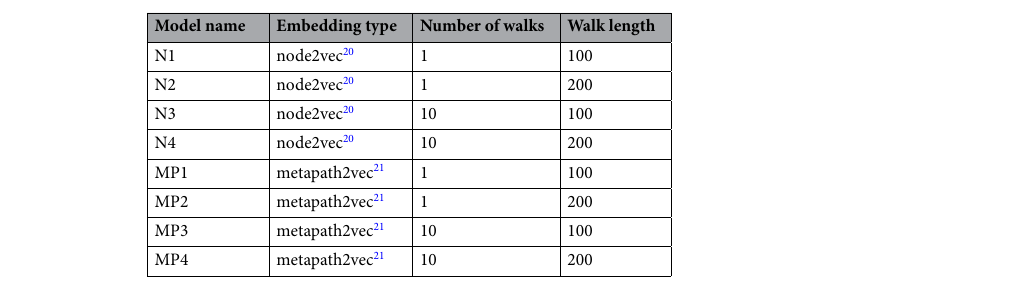
Table 4. Embedding model hyperparameters.